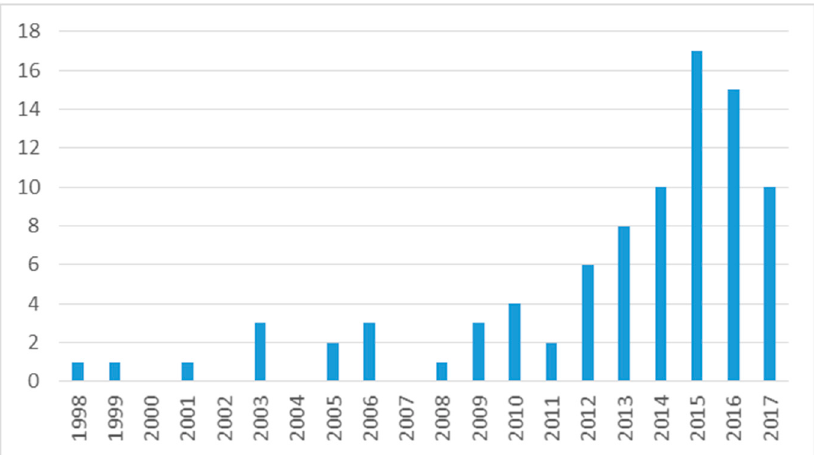
Figure 1. Temporal distribution of hits searching for the topics “Tools” AND “GIS” AND “Governance” in the Web of Science.